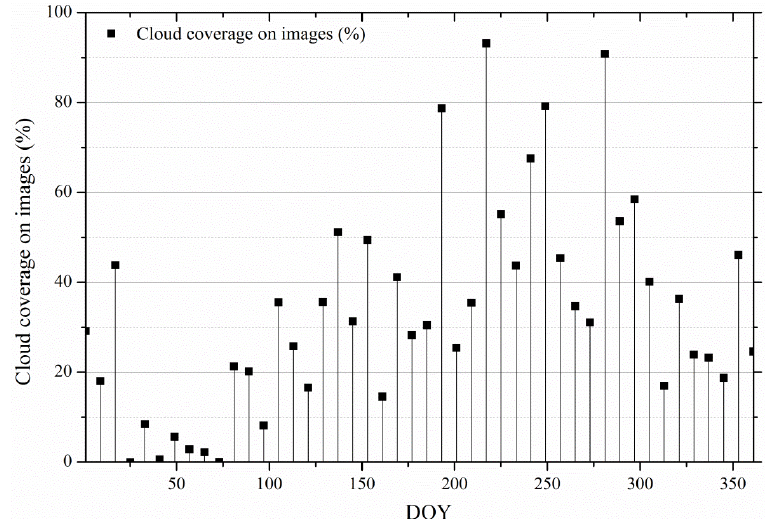
Figure 1. Cloud coverage in images. Among the 46 MODIS images, the cloud coverage of 33 MODIS images exceeds 20%, and that of 16 images exceeds 40%. During the rainy season of Vietnam (May to November, namely, day 120 to day 304), the mean cloud coverage was